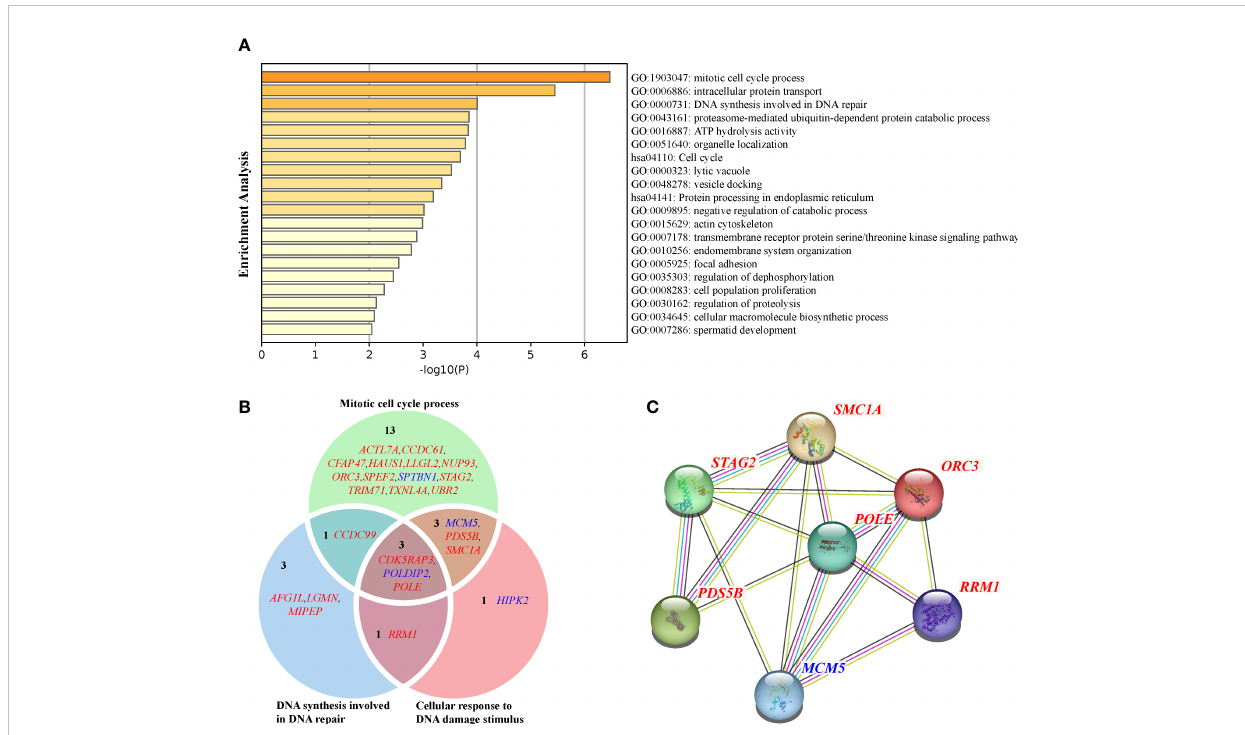
FIGURE 3 (A) GO and KEGG enrichment of the union of the REGs and PSGs. (B) Venn diagram of the GO terms (mitotic cell cycle process, DNA synthesis involved in DNA repair, and cellular response to DNA damage stimulus) related to DDR. REGs with blue fonts, and PSGs with red fonts. (C) Protein – protein interaction network of the REGs and PSGs. The edges represent protein – protein associations, blue represents “ from curated databases, ” red represents “ experimentally determined, ” yellow represents “ text mining, ” and black represents “ co-expression. ”